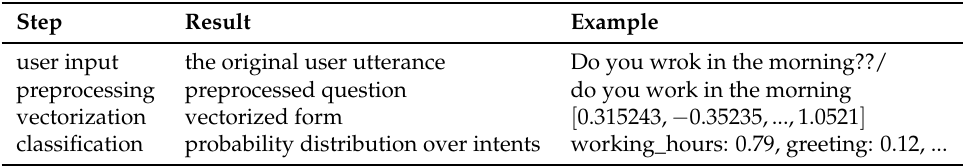
Table 1. An example of intent detection.